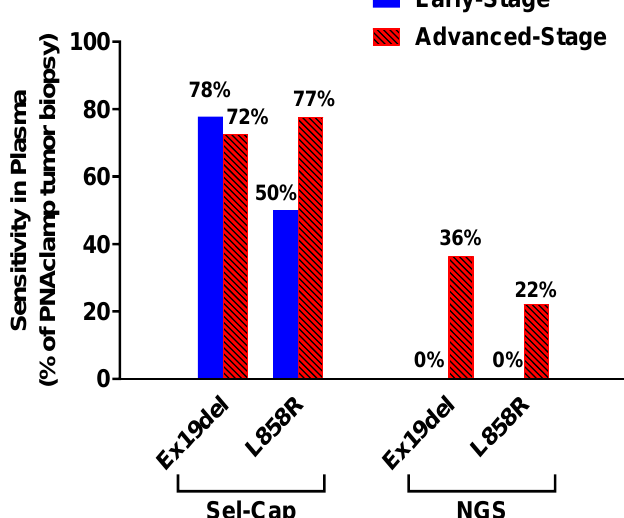
Figure 2. Comparison of sensitivity between Sel-Cap and conventional NGS liquid biopsies for two EGFR -activating mutations in NSCLC patients (n = 61, Table 1), stratified by disease stage (n = 30 and 31 for early-stage and advanced-stage, respectively). Sensitivity was calculated against paired PNAclamp tumor biopsy.